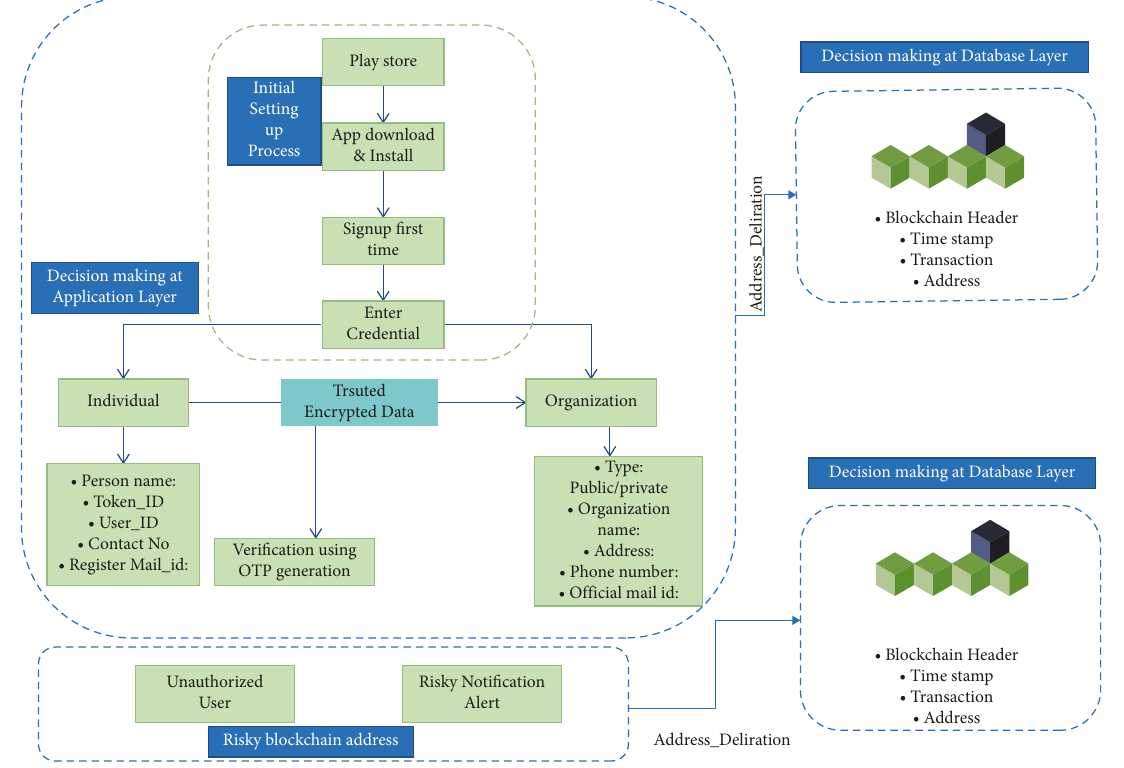
Figure 6: Proposed flow work for contactless